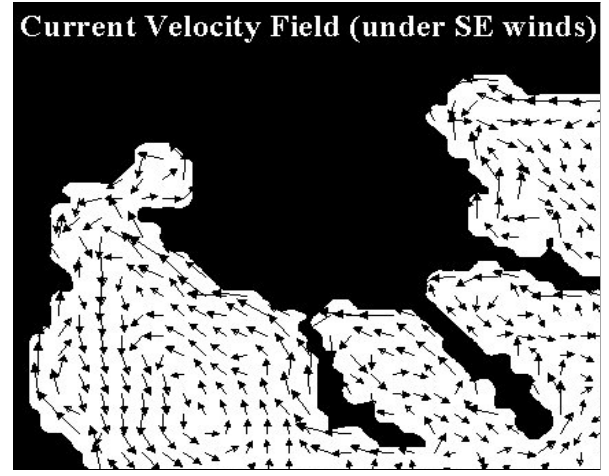
Fig. 8. Depth average currents from the model runs due to SE winds (22 September 2002).